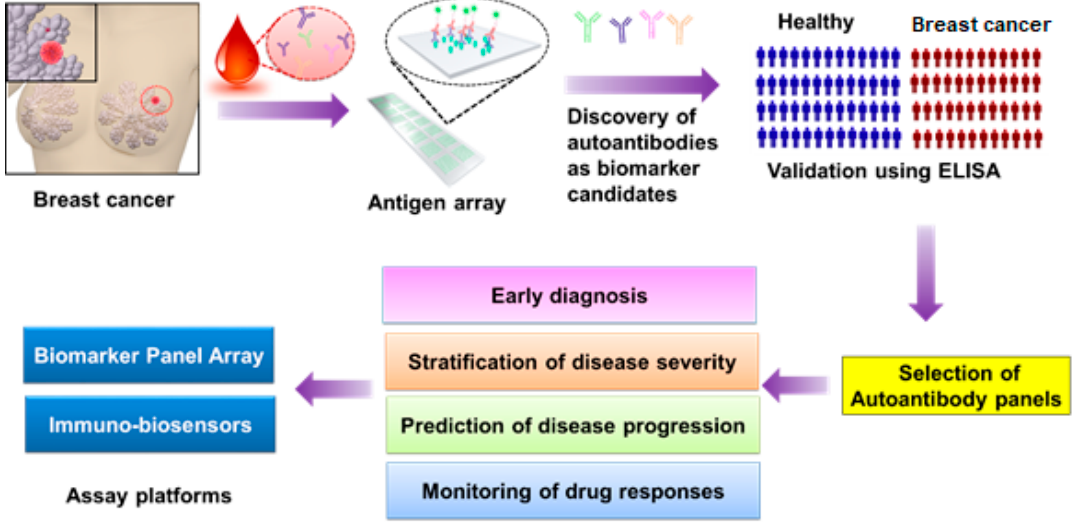
Figure 2. Flowchart of autoantibody biomarker discovery and detection in breast cancer using antigen arrays and ELISA. First, a drop of blood from breast cancer (BC) patients is subjected to an antigen array for a high-throughput screening of autoantibodies that specifically bind to breast cancer antigens on an array. Second, promising autoantibody candidates are selected from the array screening and validated in a large cohort of patients using ELISA, which can be used for early diagnosis, disease stratification, prediction of disease progression, or monitoring of drug responses. Finally, according to the function of each autoantibody biomarker or biomarker panel, biosensors or autoantigen-panel chips could be designed and fabricated for clinical use in breast cancer.